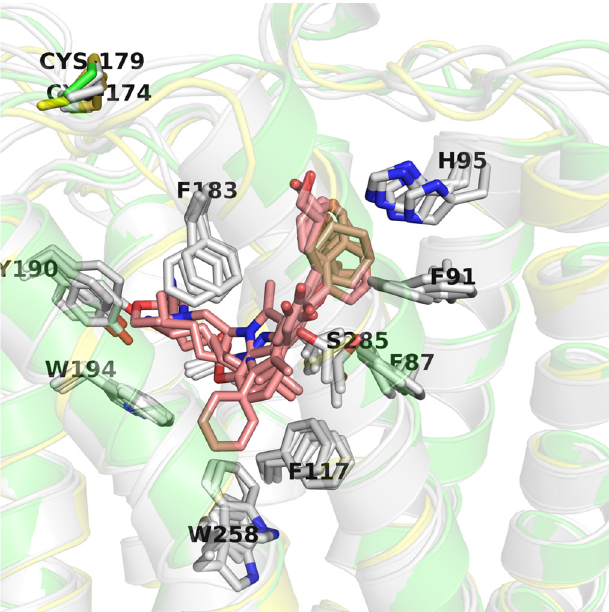
Figure 7. Comparison of CB2 structures available in the Protein Data Bank (PDB). Here, an inactive CB2 conformation (5ZTY) is shown in green and is the best performing in virtual screening (VS), active conformation (6KPF) is shown in yellow, and other CB2 active structures are shown in grey. Residues are labeled according to the 5ZTY numbering.